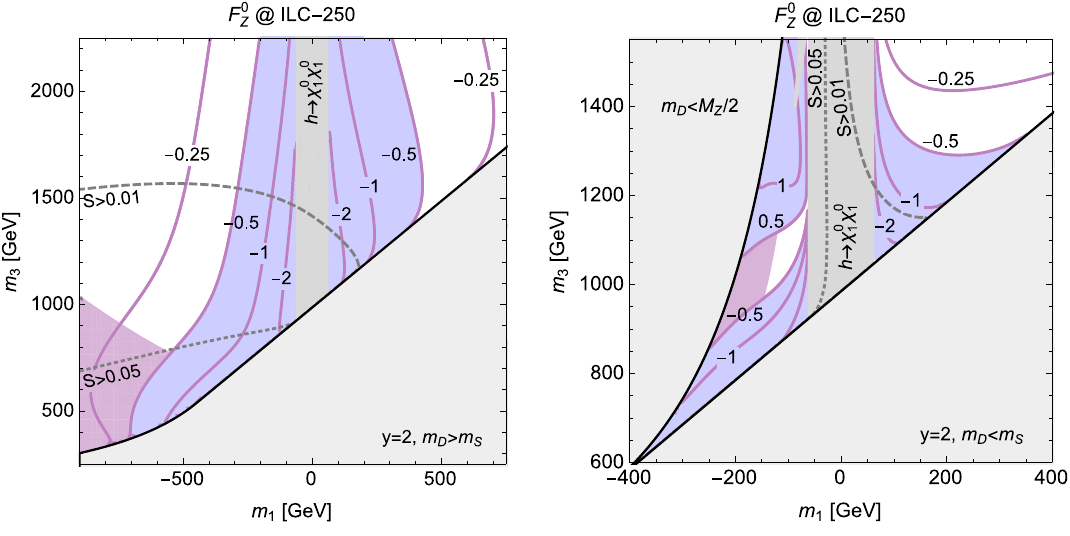
Figure 6 . Form factor Re[ F 0 ;ee ] as a function of m 1 and m 3 for y = 2 and m D > m S (left) or Z m D < m S (right). Purple curves show constant values of Re[ F 0 ;ee ] in percent; in purple areas, Z (cid:31) 0 is the lightest state. Blue areas can be probed at future lepton colliders. Dark gray bands are 2 excluded by LHC bounds on the Higgs width. Regions below/left of the dotted (dashed) gray lines are in tension with the S parameter at LEP (can be probed at a